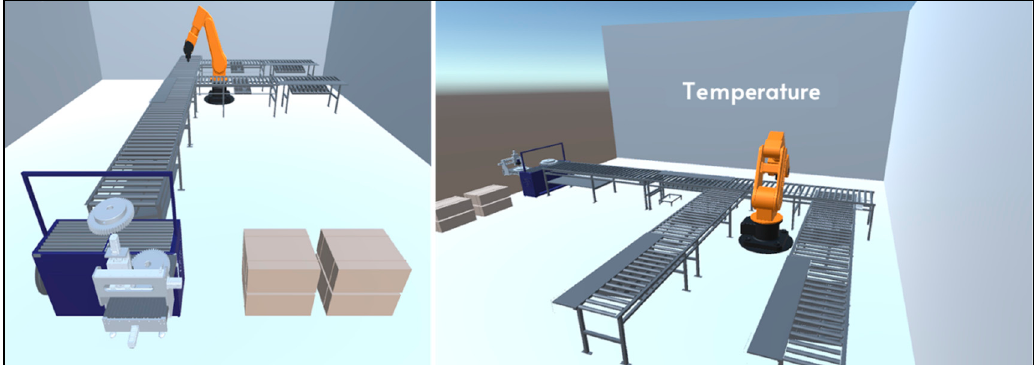
Figure 9. An example of the production line visualization in the system. Visualizations were performed for each element by using color labels from green to red for robotic arm temperature, dust density, CNC frequency, and environment temperature (Figure 10).